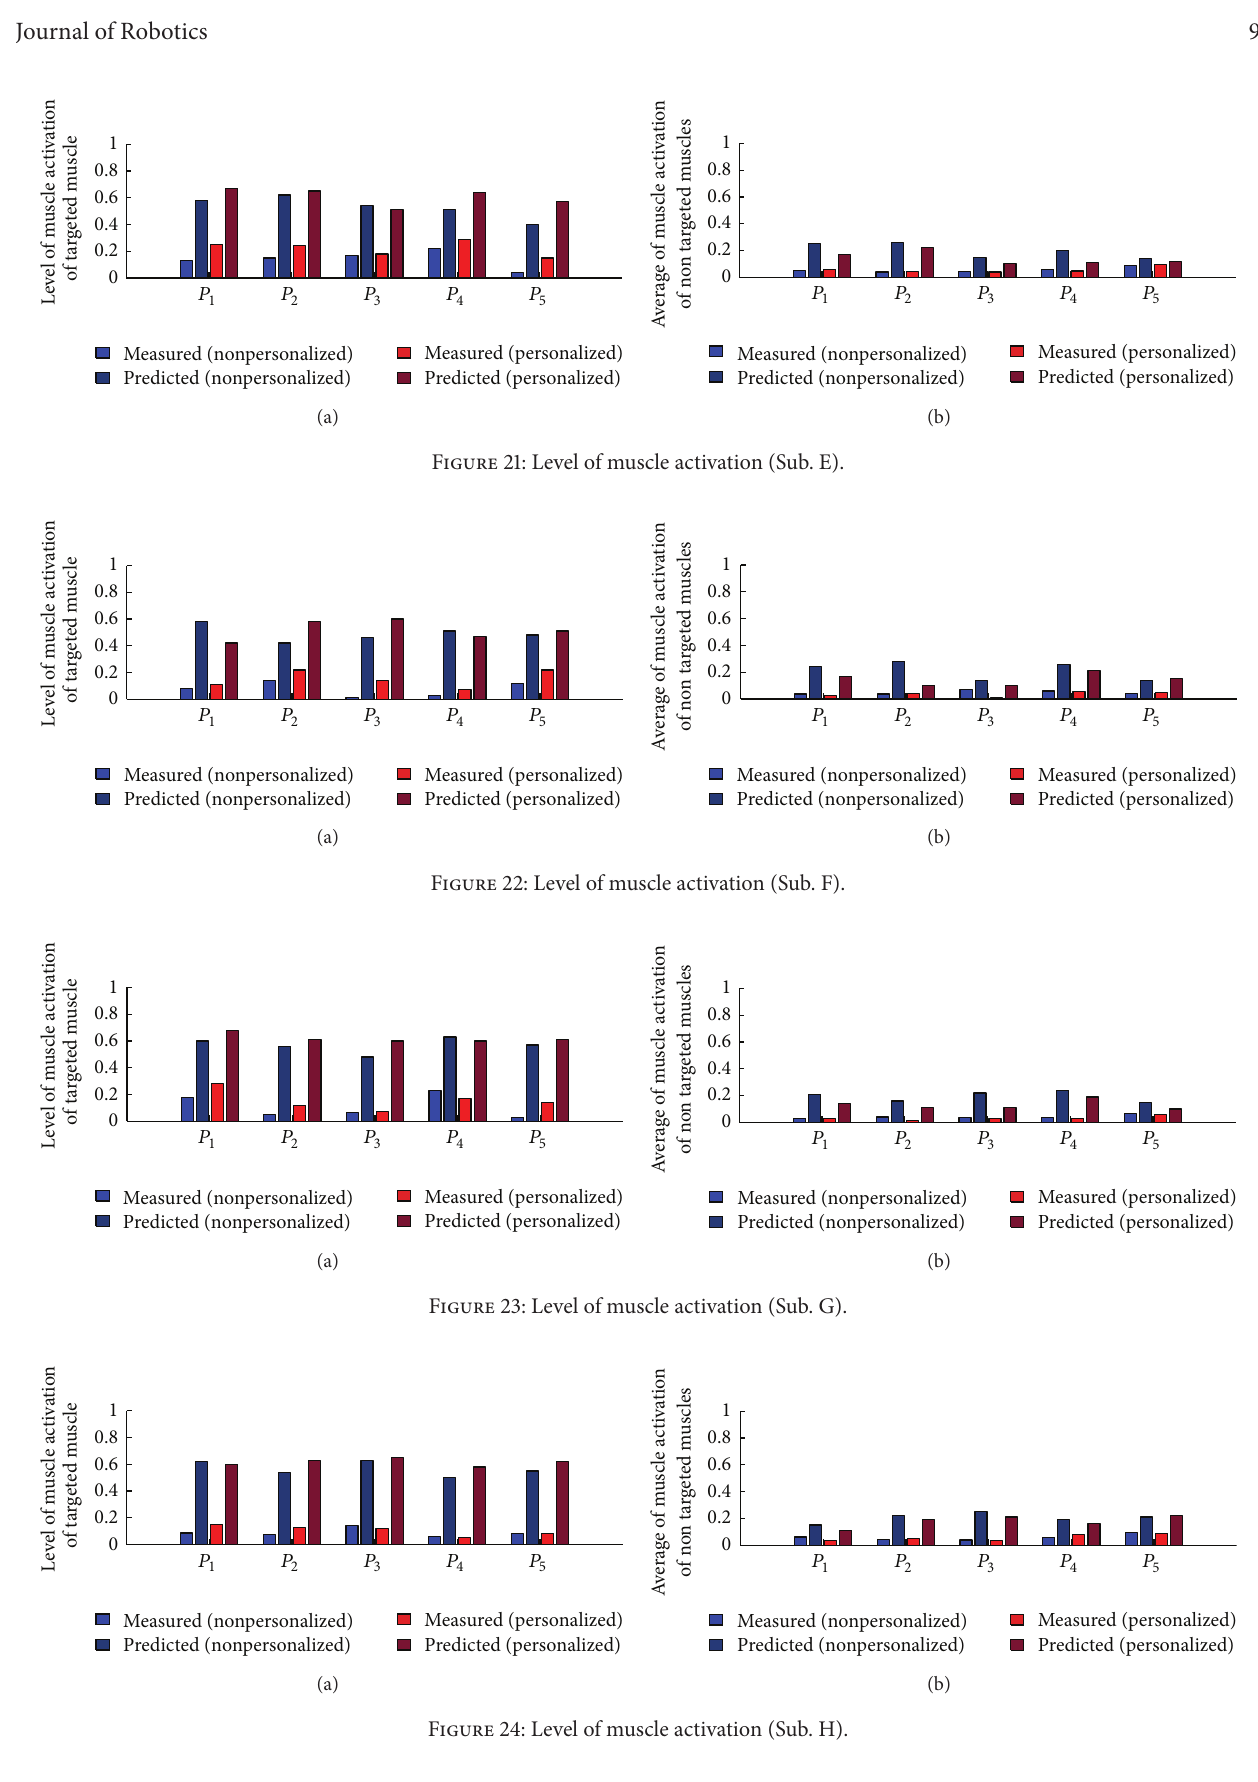
Figure 24: Level of muscle activation (Sub.